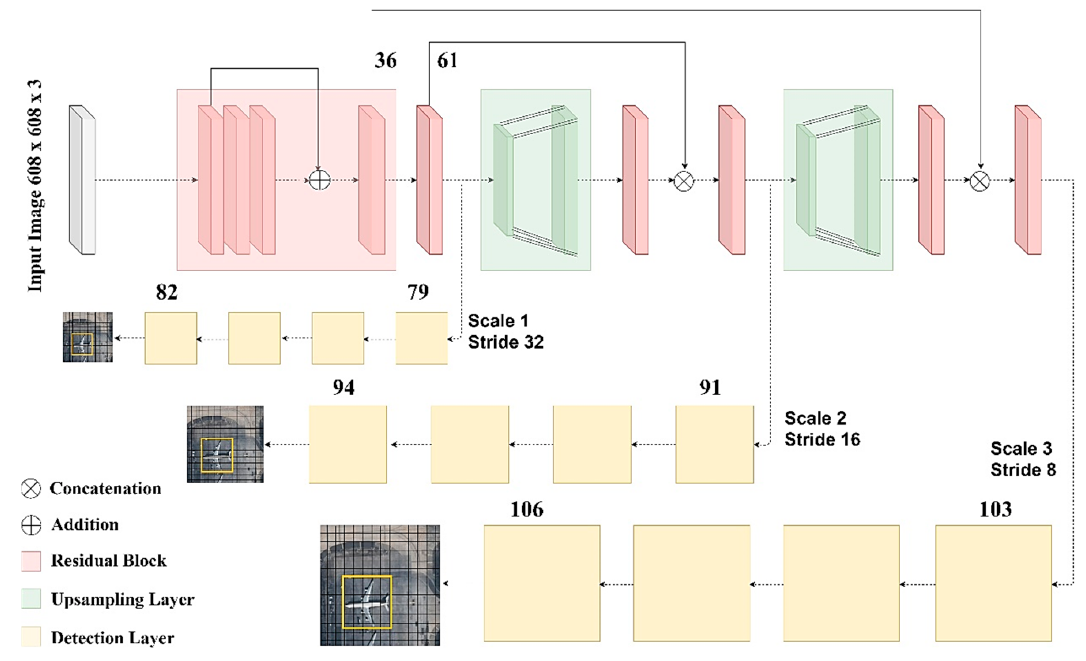
Figure 8. Yolo v3 architecture schema.